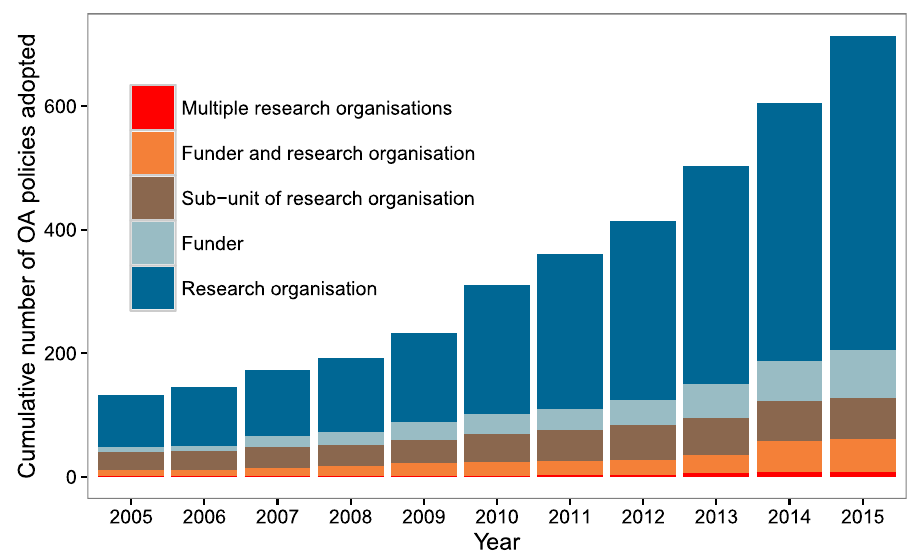
Figure 3. Cumulative number of Open Access policies adopted by multiple research organisations, funder and research organisation, sub-unit of research organisation, funder, and research organisation. Figures are given at the beginning of each year. Source: ROARMAP, accessed March